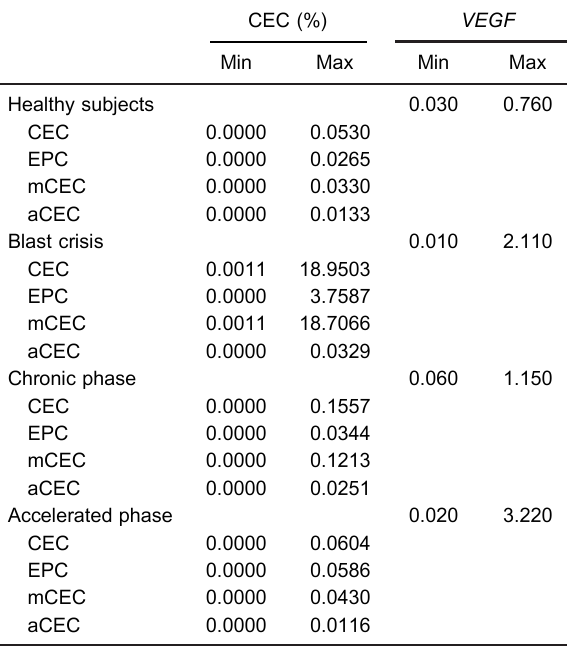
Table 1. Minimum and maximum percentages of CECs and VEGF gene